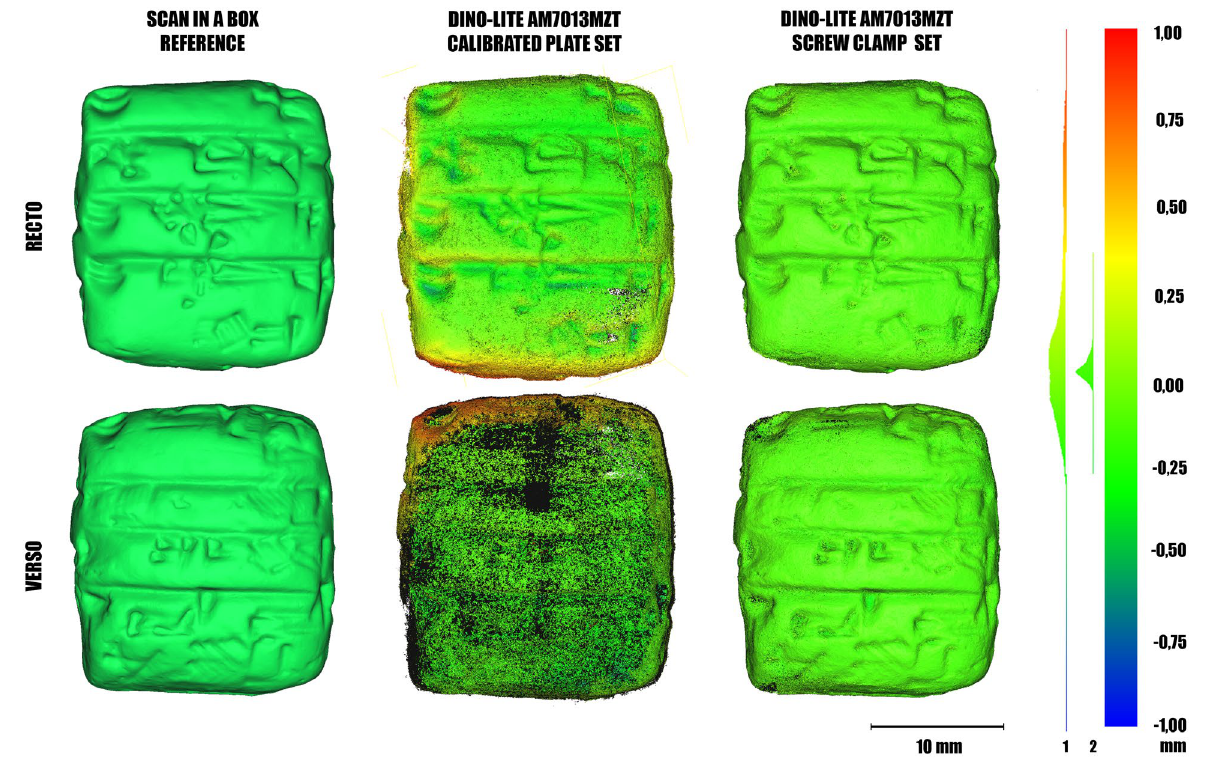
Figure 11 . Global deviations of the photogrammetric dense clouds obtained using the calibrated plate and the screw clamp as support, compared with the reference model of the SCAN in a BOX (recto and verso side view).